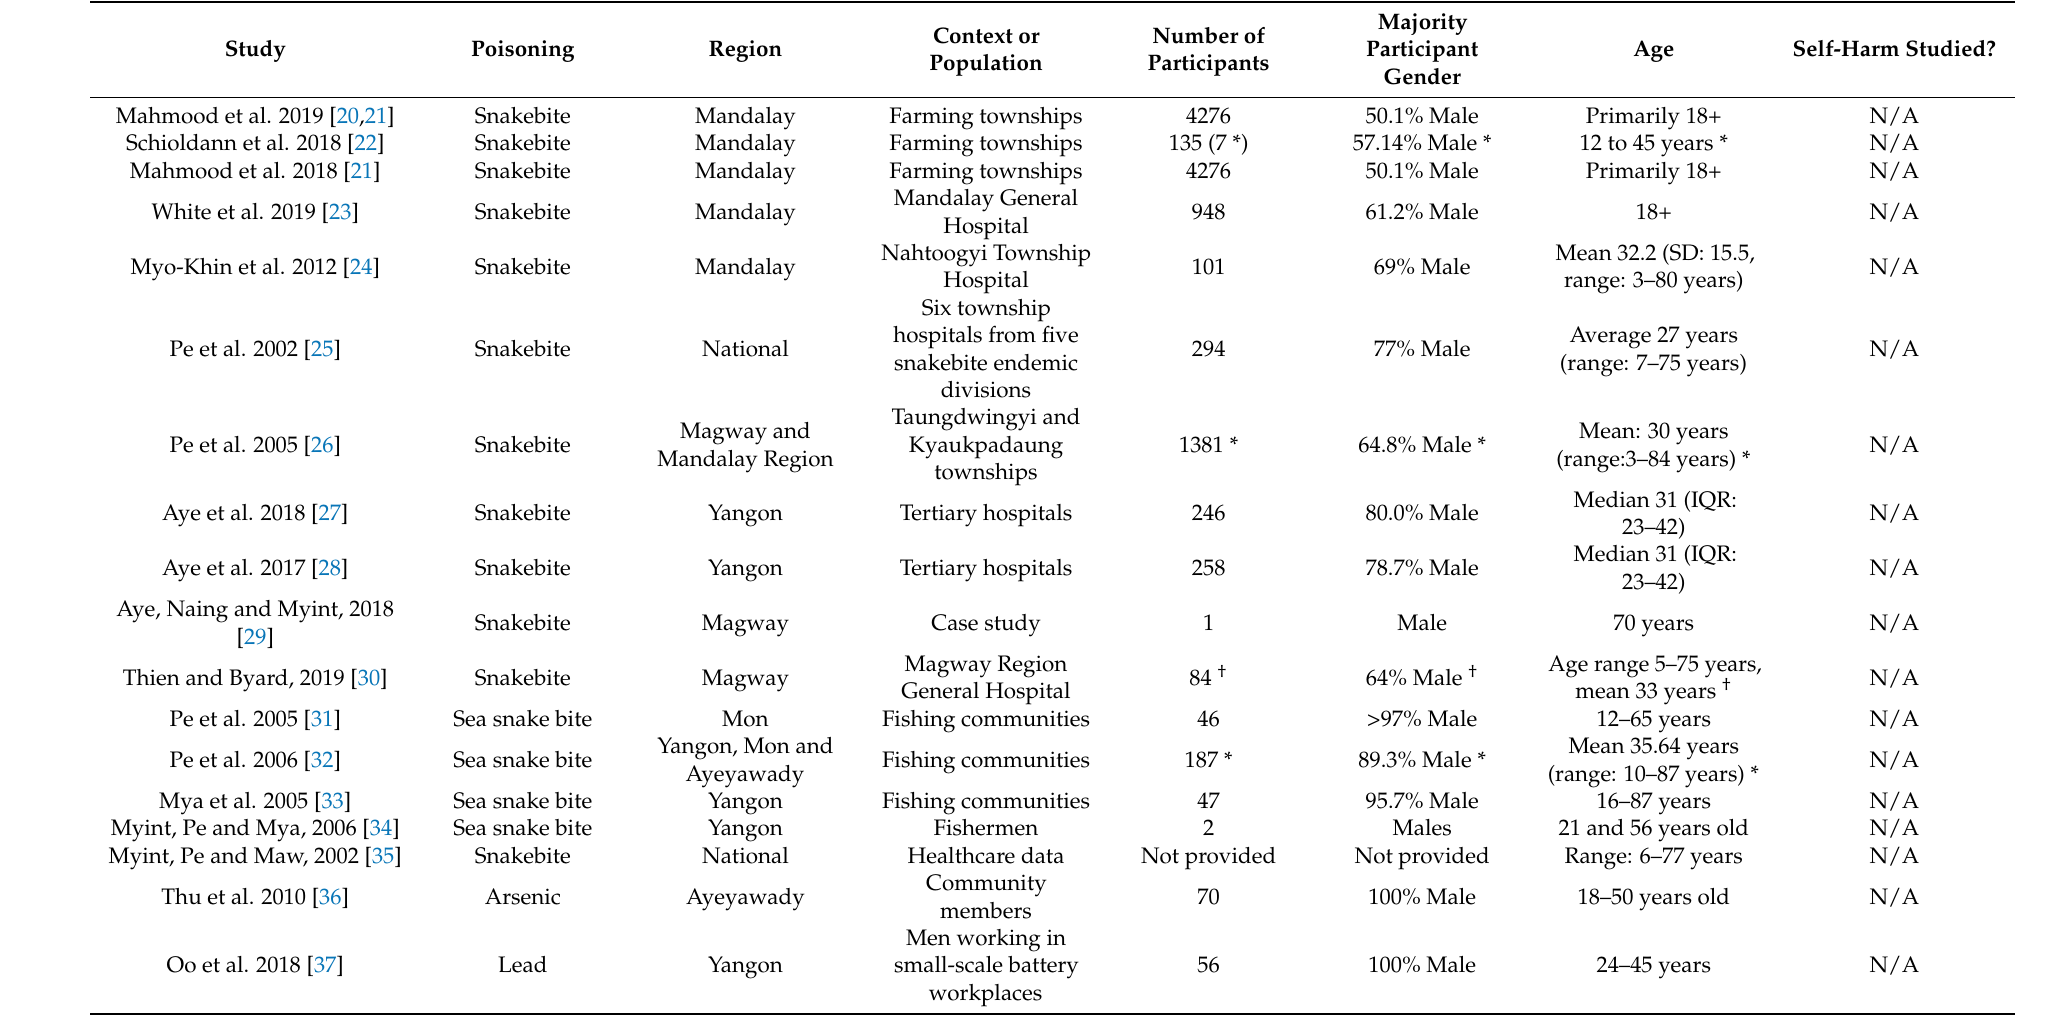
Table 2. Study location and participant demographic